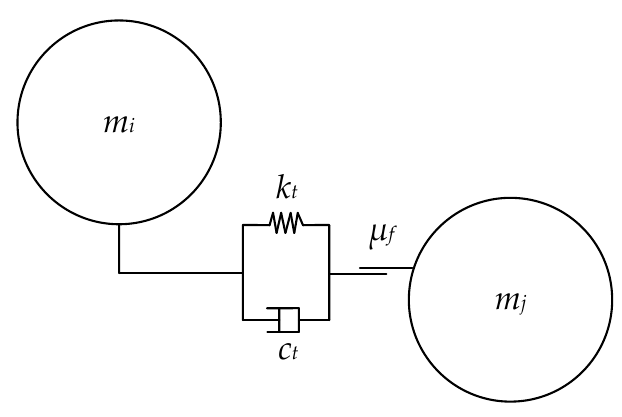
Figure 3. Particle tangential collision contact model.